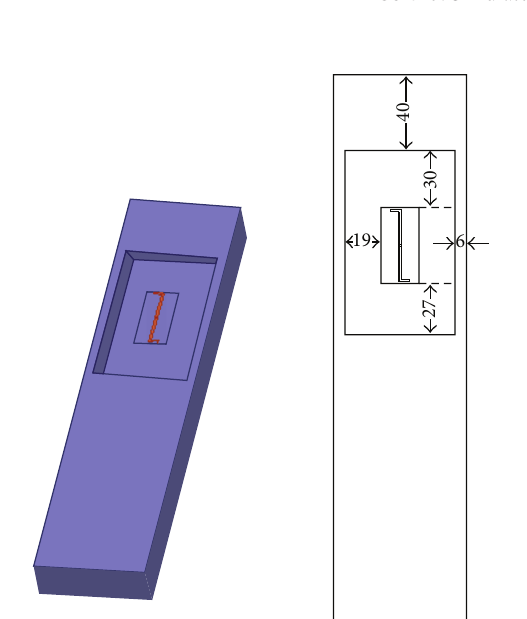
Figure 3: Simulated radiation patterns at 2.4 GHz.